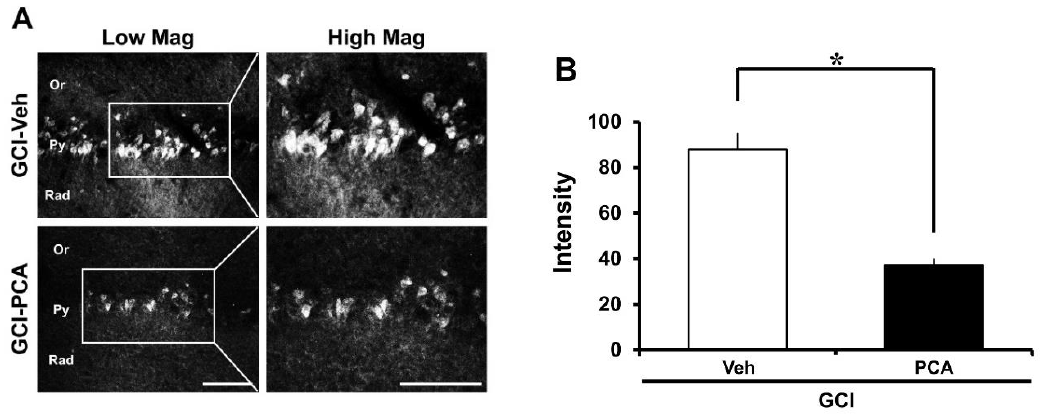
Figure 7. PCA administration decreases the intracellular free zinc level in the CA1 region. Ischemic neuronal death is promoted by zinc release and accumulation. However, oral treatment with PCA for 3 days reduces the intracellular free zinc level. ( A ) displays photomicrographs of TSQ fluorescence staining in CA1. After insult, the intracellular free zinc levels were increased. However, we confirmed that zinc levels were significantly decreased in the group that was administered PCA after ischemia. Scale bar = 100 µ m ( B ) the bar graph indicates the TSQ fluorescence intensity from CA1. Data are mean ± S.E.M., n = 4 from each global cerebral ischemia group and ischemia group with PCA. * Significantly different from the vehicle-treated group, p < 0.05.